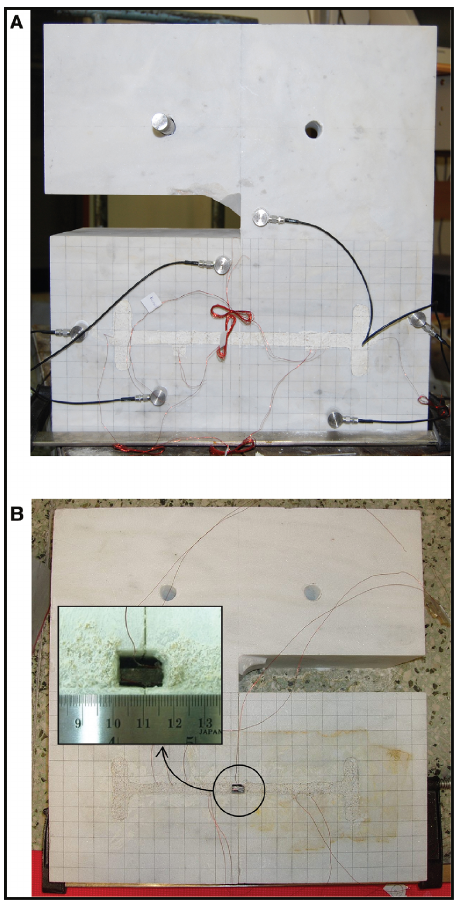
Figure 7: The two types of specimens: Completely covered (A) and partially uncovered connector